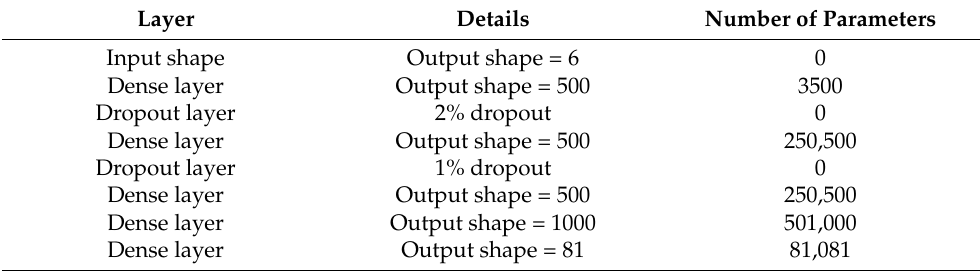
Table 3. Summary of final SNN model